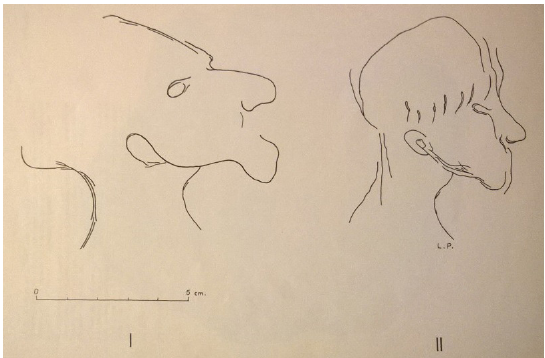
Figure 23. Group δ, examples of Hand δ2: Obs. 20(I-II) (from Pales,